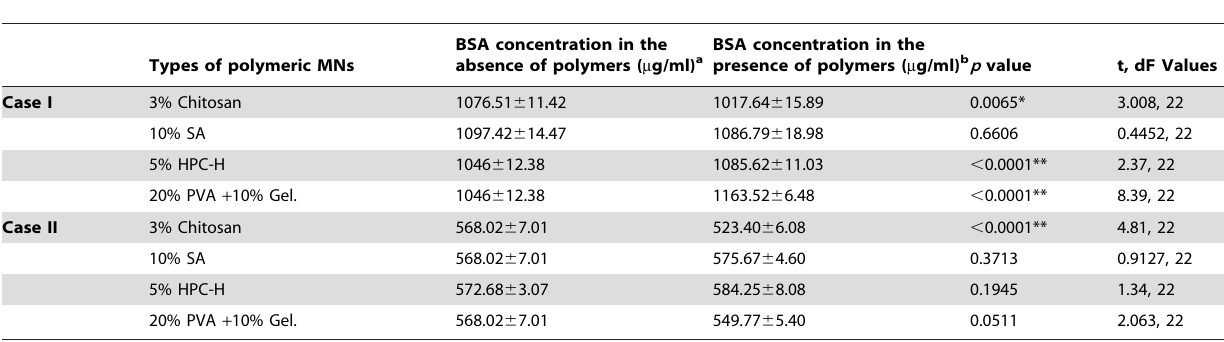
Table 6. Analysis of the interactions of BSA with various polymeric MNs, where the BSA content was determined with BCA method (means 6 SEM, N=